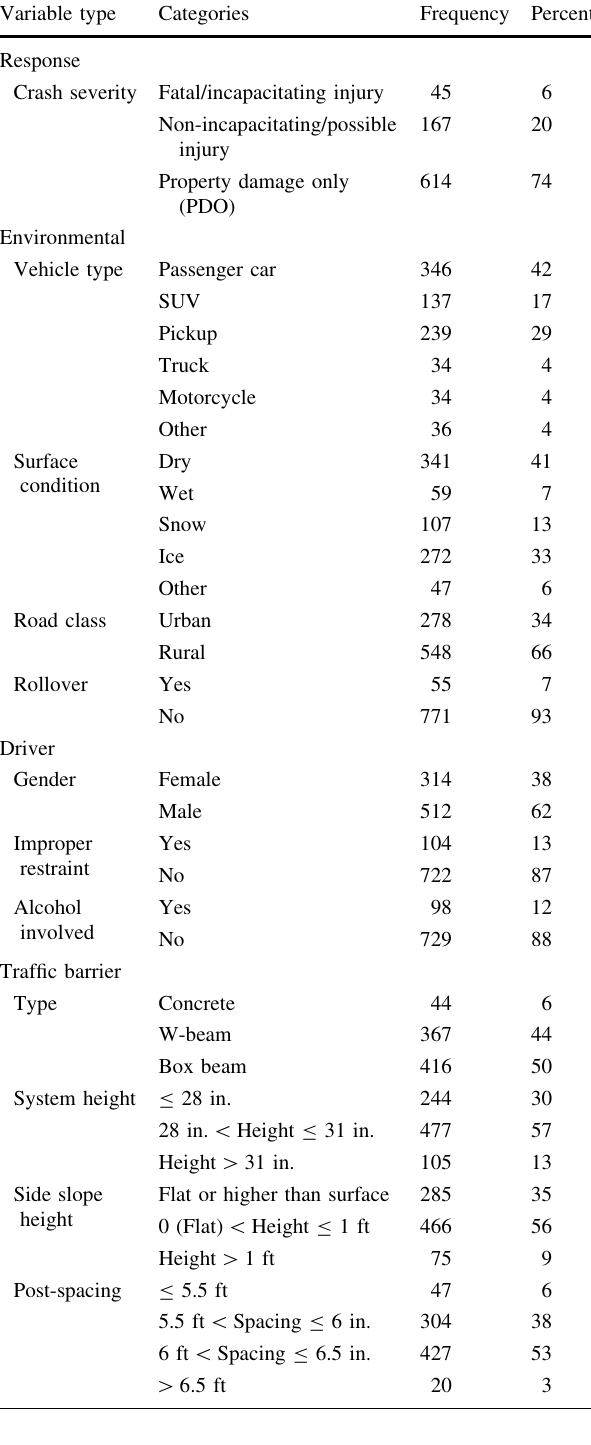
Table 3 Statistics of dependent and significant independent variables for crashes involving traffic